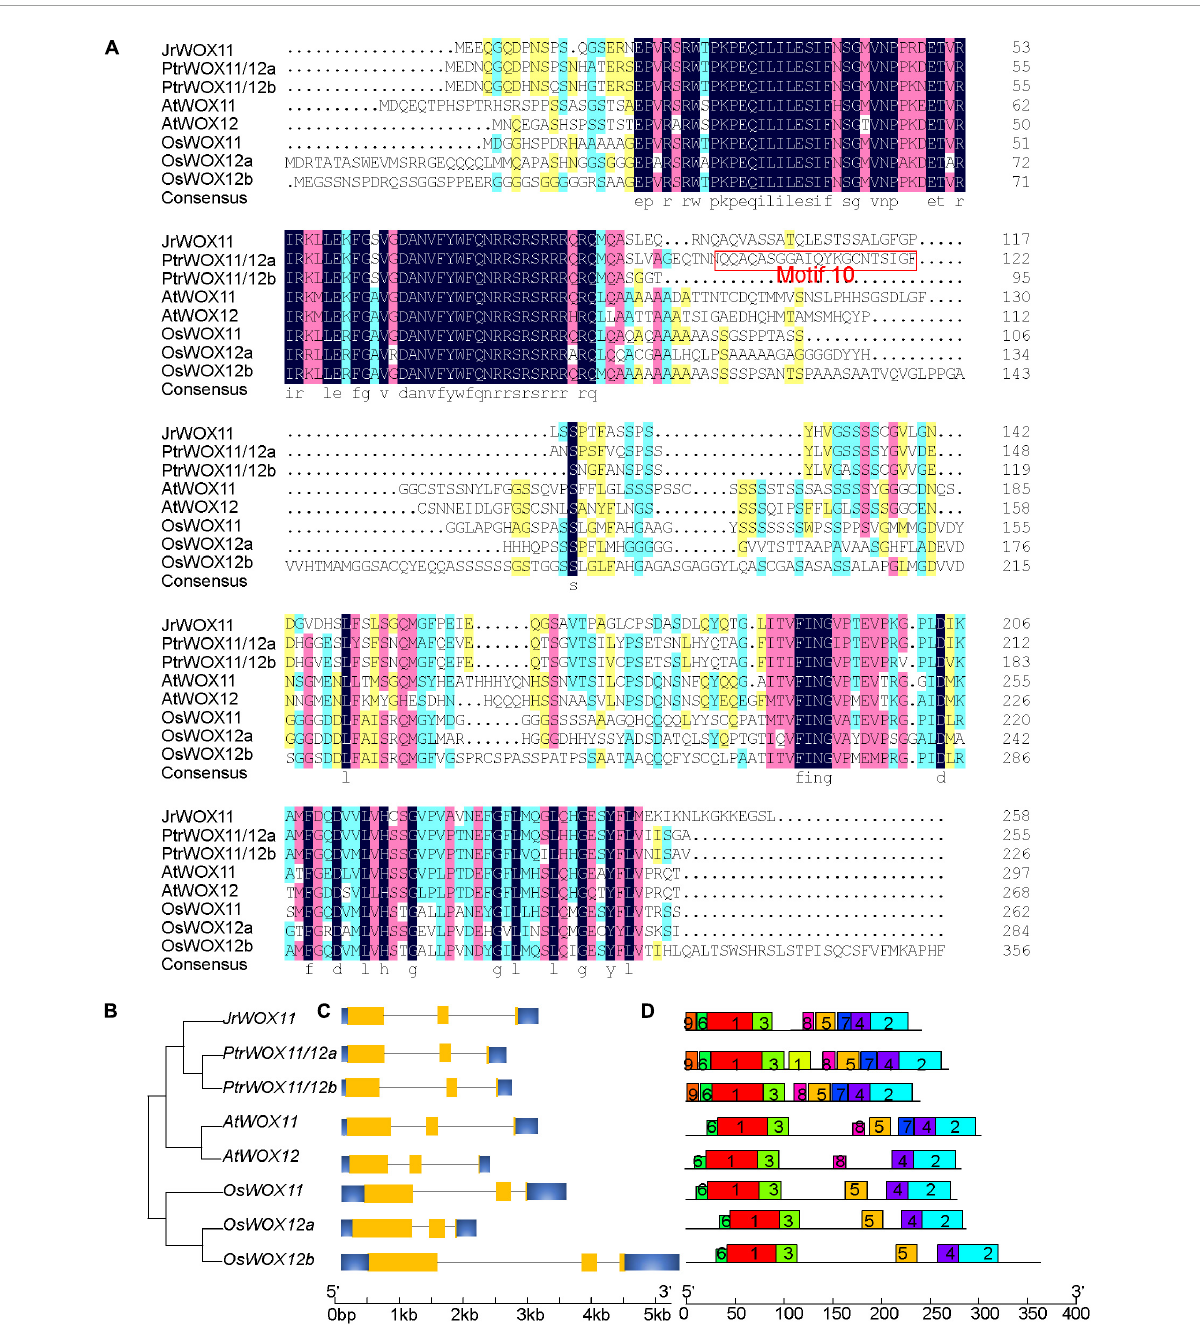
FIGURE1 Identification and characterization of cloning of the JrWOX11 gene. (A) Sequence alignment of homologous WOX11/12 proteins. Protein sequences were obtained from NCBI and are shown in Supplementary Table 2 . (B) Phylogenetic tree based on full-length coding sequences of WOX11/12 genes. (C) Gene structure analysis of WOX11/12 genes. (D) Motifs analysis of WOX11 proteins. MEME software was used to search motifs, and then redraw the map with the software TBtools (Chen et al., 2020). Motif10 was marked with a red box in panel (A)